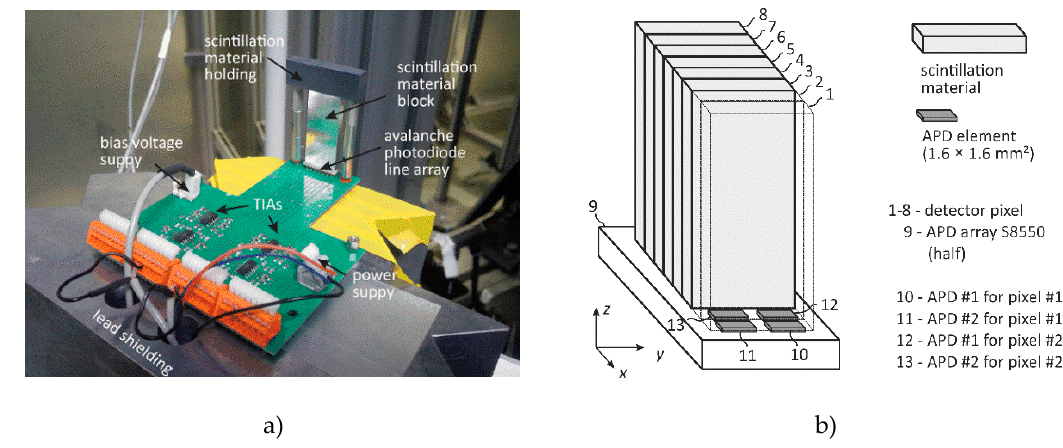
Figure 10. ( a ) Test configuration of a multi-plane detector module and ( b ) details on the coupling of the scintillation blocks onto the corresponding avalanche photodiodes of the APD array